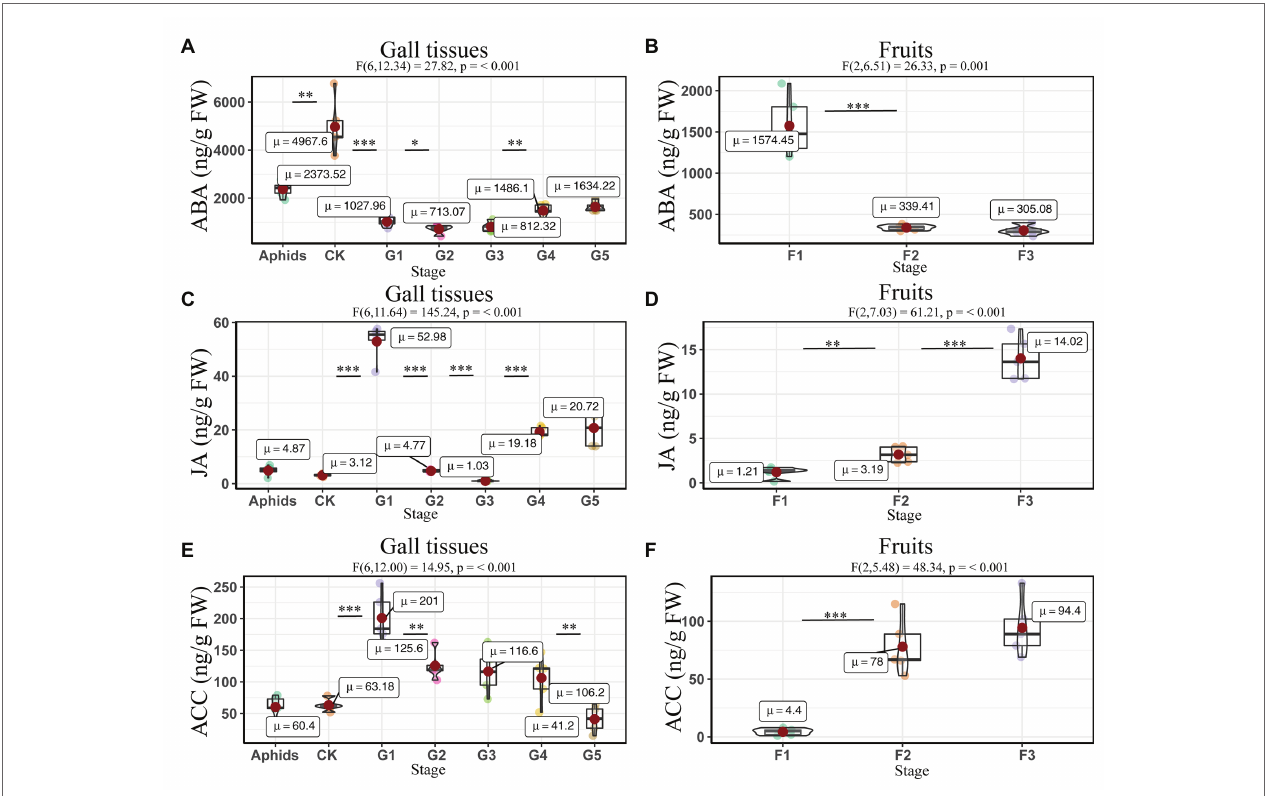
FIGURE 6 | Quantitative analysis of defense related phytohormones concentrations in larch adelgids, gall tissues, and cones of P. koraiensis . The abscisic acid (ABA), jasmonic acid (JA), and 1-aminocyclopropane-1-carboxylic acid (ACC) concentrations in gall tissues and normal branches (A,C,E) and cones (B,D,F) , respectively. CK = normal branches without gall. Data are presented in nanograms per gram of fresh weight (ng/g FW), and boxplots display the minimum, first quartile, median, third quartile, and maximum for each stage in the given tissues. Red point = mean value and horizontal black line inside the box = median value. The shape of the boxplots indicates distribution of results. The mean differences were compared using t -tests. * Indicates that the value of p is less than 0.05. ** Indicates that the value of p is less than 0.01. *** Indicates that the value of p is less than 0.001. These results shown are the average ± SD and performed one-way ANOVA test among three or more groups. ω p 2 = partial omega